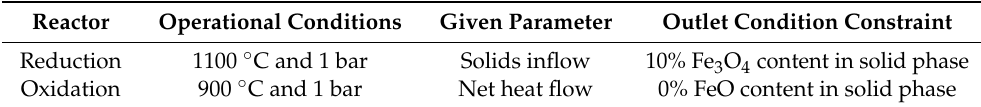
Table 4. Reactor operational conditions, given parameters, and outlet condition constraints.